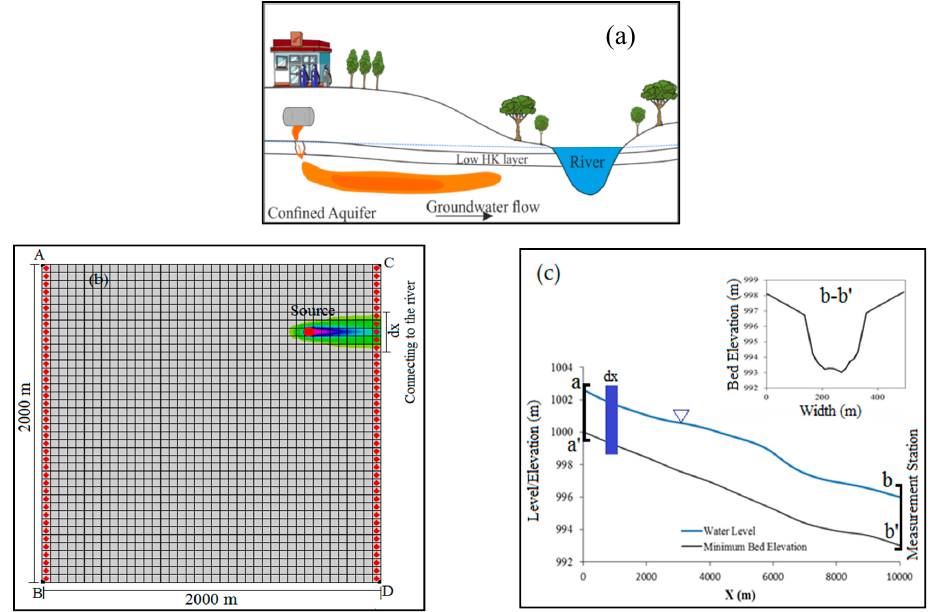
Figure 13. ( a ) Sketch view of the case study; ( b ) the plan view of the study area and the distribution of contaminant source after 182 days; ( c ) water surface profile in the river and cross-section at the chainage 10 km. Table 5. Case 2: hydraulic and geometry characteristics.